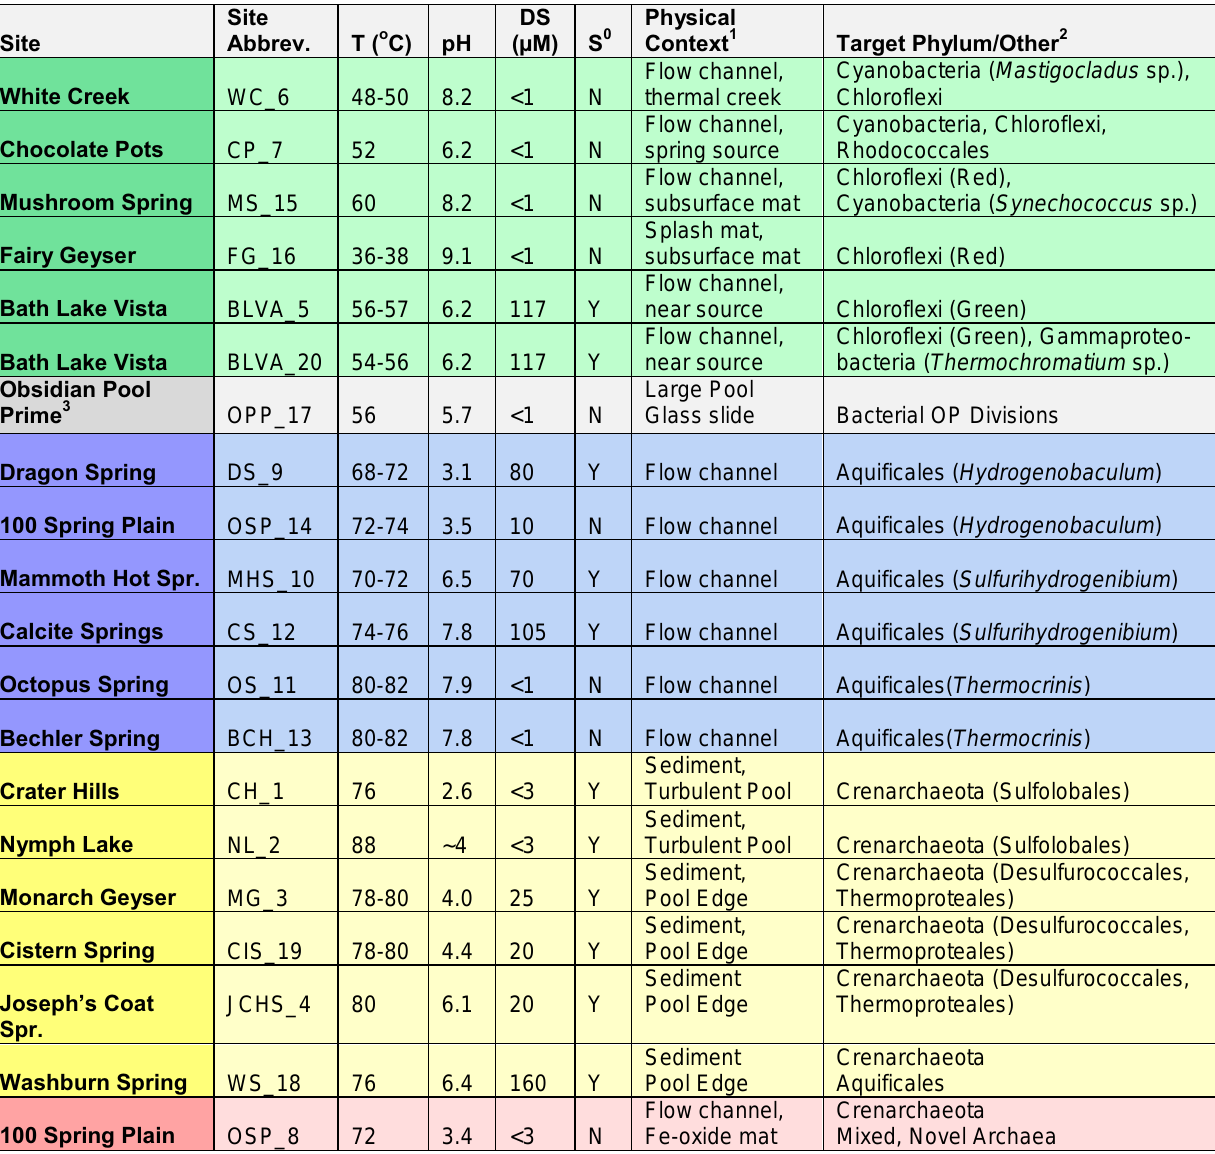
Table 1 | Site names, abbreviations, and minimal set of environmental metadata necessary to separate different microbial community types (temperature, pH, dissolved sulfide or the presence of elemental S; Figure